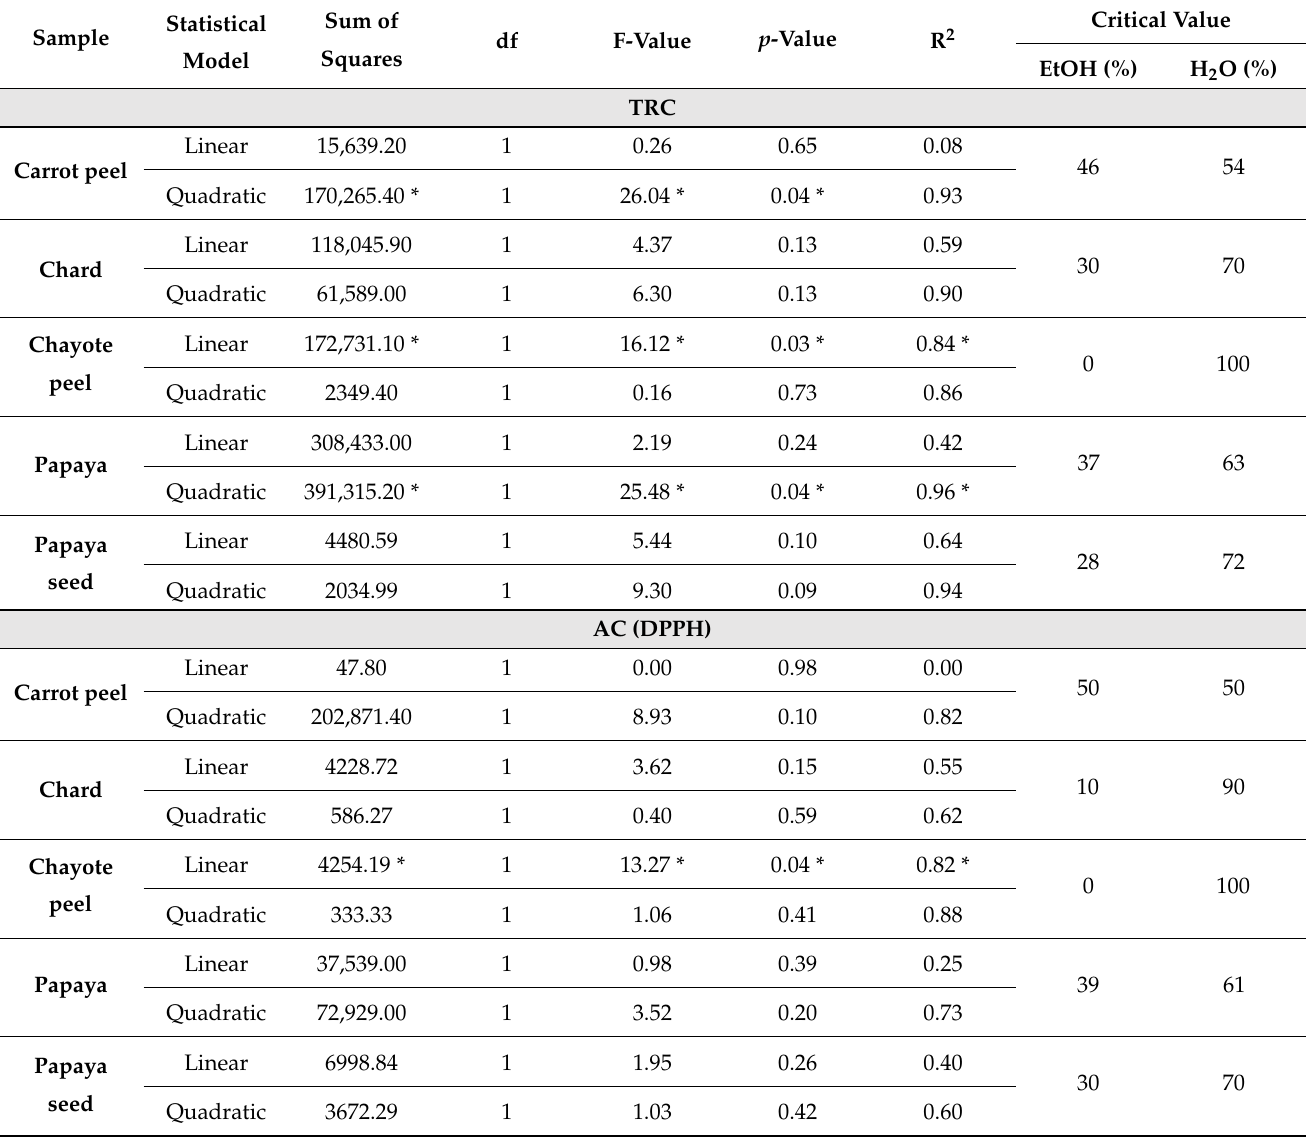
Table 1. Analysis of variance [41] for the extracts of the five fruit and vegetable by-products (FVB), considering the total reducing capacity (TRC) and antioxidant capacity (AC) by the DPPH